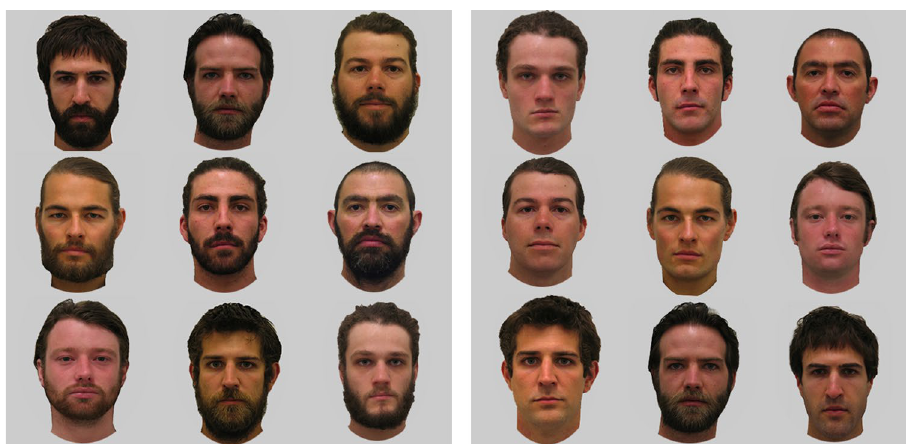
Figure 2. Example search arrays from trials in Study 1. Left: Non-target trial containing uniformly bearded males. Right: A bearded target trial containing one bearded male (bottom row, centre column) in a clean-shaven